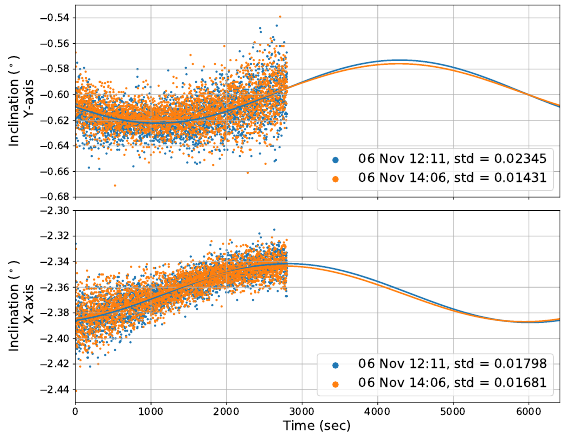
Figure 8. Inclination measurements of two scans taken at 6 November 2020 and the standard deviation of the